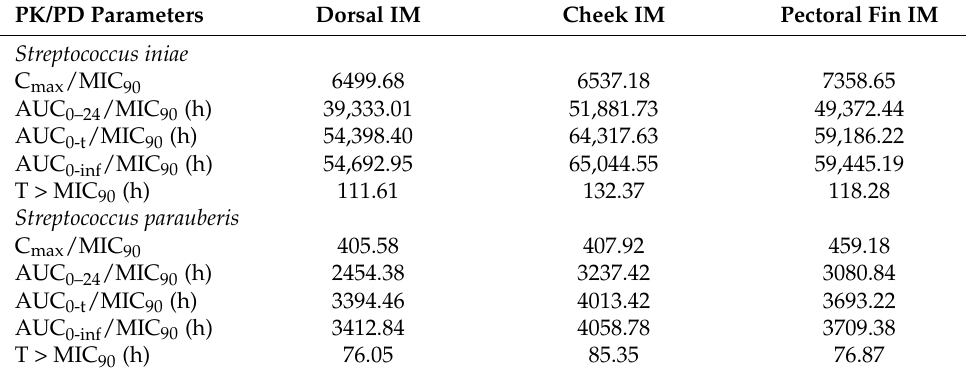
Table 2. Pharmacokinetic/pharmacodynamic integration of amoxicillin in serum of olive flounder ( Paralichthys olivaceus ) following intramuscular (dorsal, cheek, and pectoral fin) injection at a dosage of 40